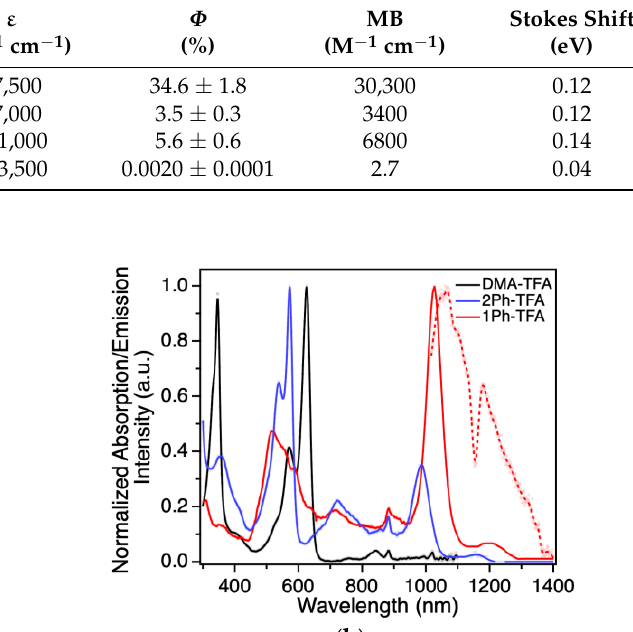
Table 1. Photophysical data for BODIPY dyes in CH 2 Cl 2 .